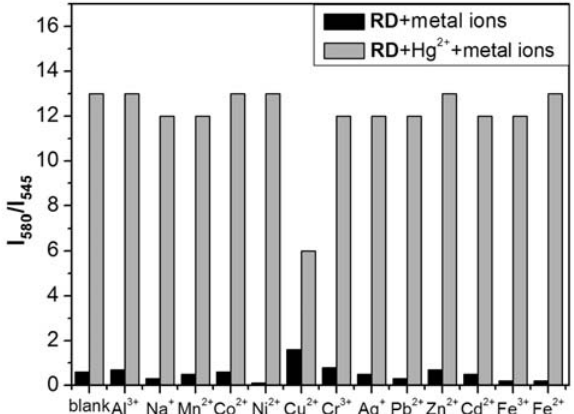
Figure 8. Selective responses of RD (10 μM) to 10 μM Hg 2+ in the presence of 10 μM various other